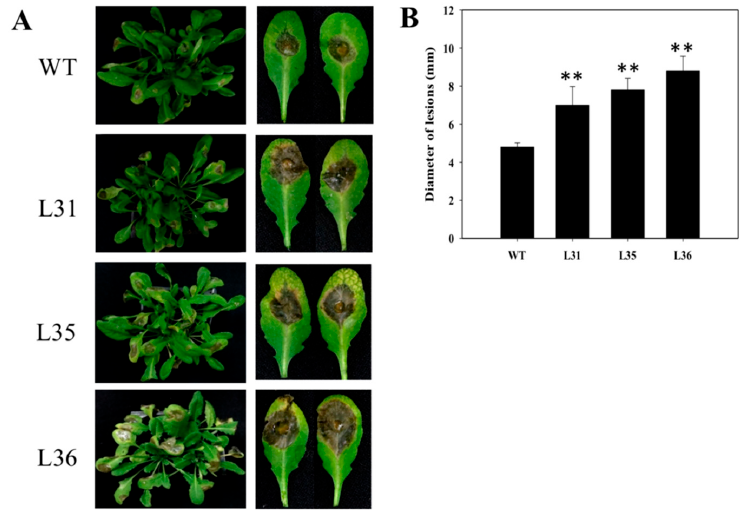
Figure 2. The performance of VqSTS36 transgenic Arabidopsis subjected with Botrytis cinerea . ( A ) The symptom of plants subjected with B. cinerea after 5 days. ( B ) Statistics of lesions diameter. Data represent mean values ± SD from three independent experiments. Asterisks indicate significant differences between WT and transgenic lines as determined by Student’s t -test (** p < 0.01).